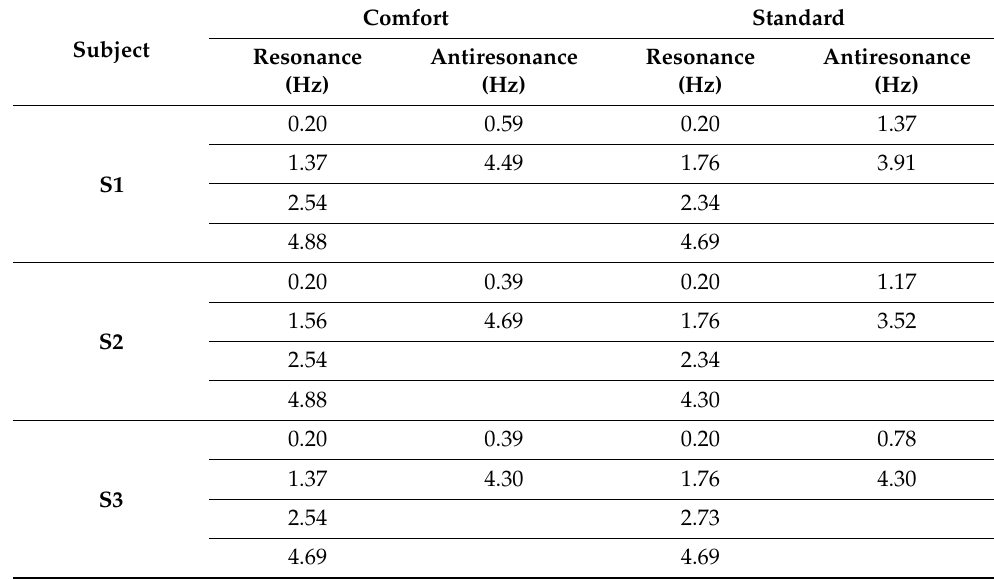
Table 2. Main resonance and antiresonance frequency values for comfort and standard seats of AP train.